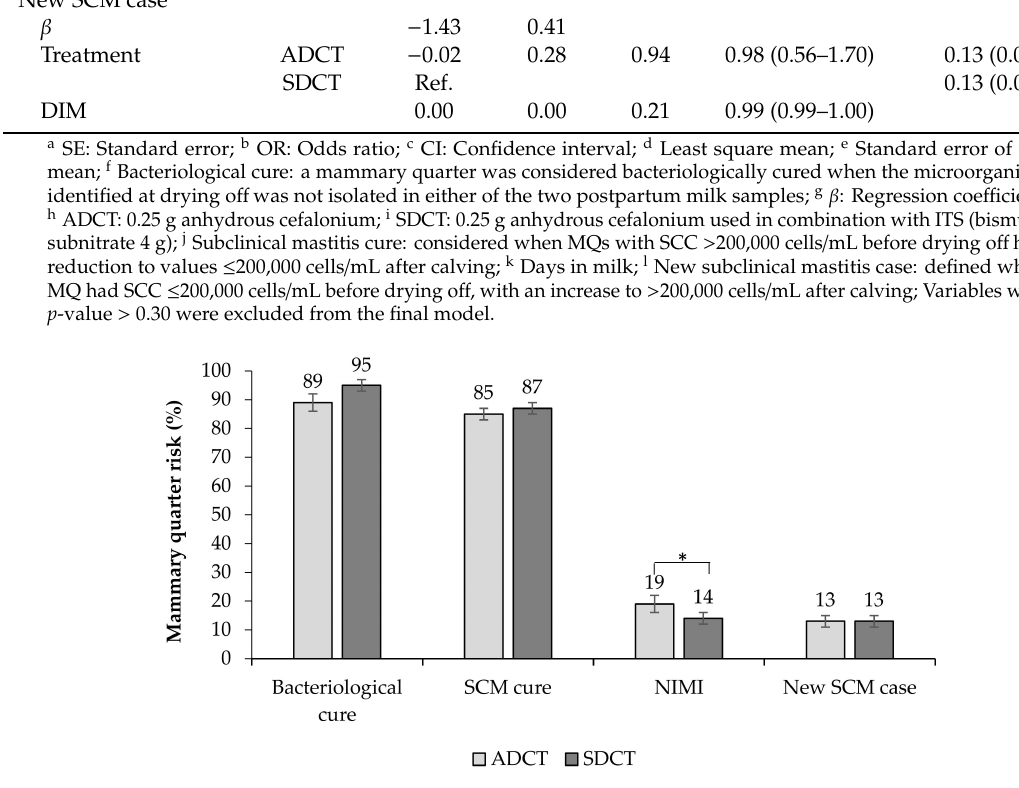
Figure 2. Risk of cure (bacteriological and of SCM), new SCM cases, and new intramammary infections (NIMI) according to the microbiological and somatic cell count (SCC) results of mammary quarters of